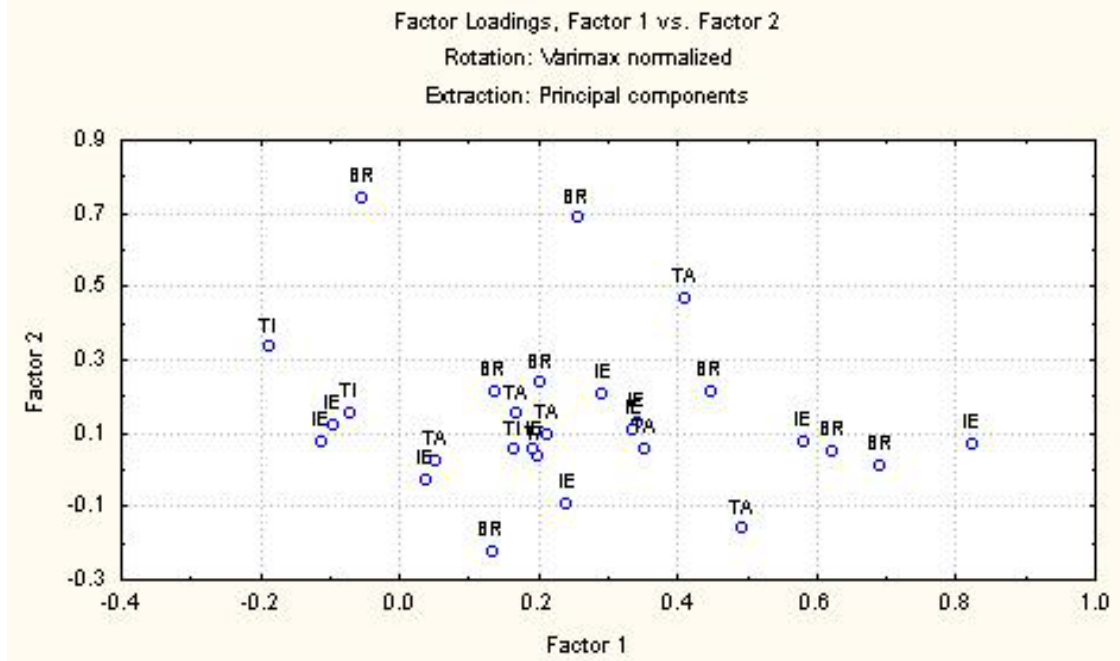
Figure 4: Factor analysis – classification model Table 4: Summary of Chi- squared tests for possible